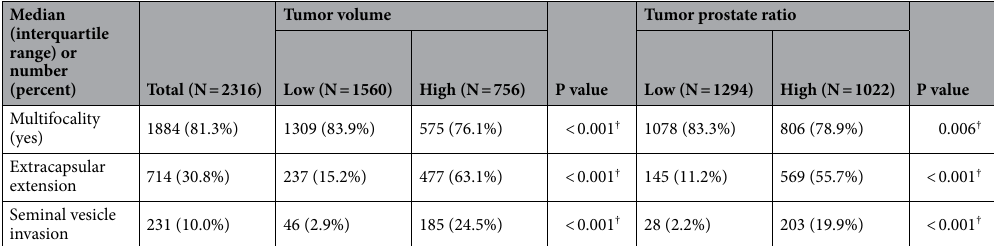
Table 1. The clinical characteristics and pathologic outcomes according to tumor volume and tumor prostate ratio. ECE extracapsular extension, GS Gleason-score, NCCN National Comprehensive Cancer Network, PSA